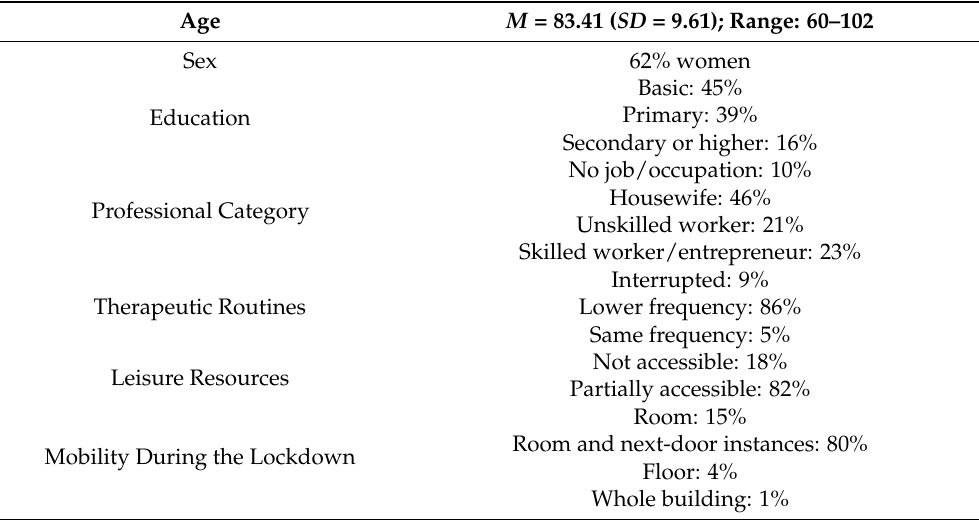
Table 1. Mean age, educational level, professional category, and lockdown circumstances.